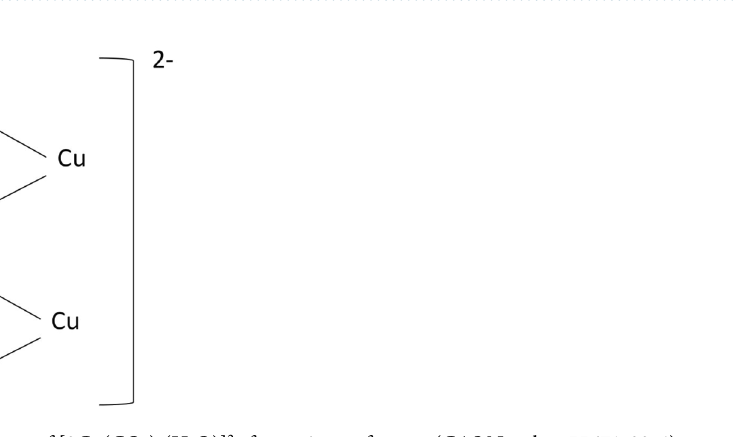
Figure 10. The carboxylate attachment to CuO surface showing different styles of attachment; where point ( a ) represents the predictive bi-dentate, point ( b ) represents the predictive uni-dentate and point ( c ) bridging ligand.